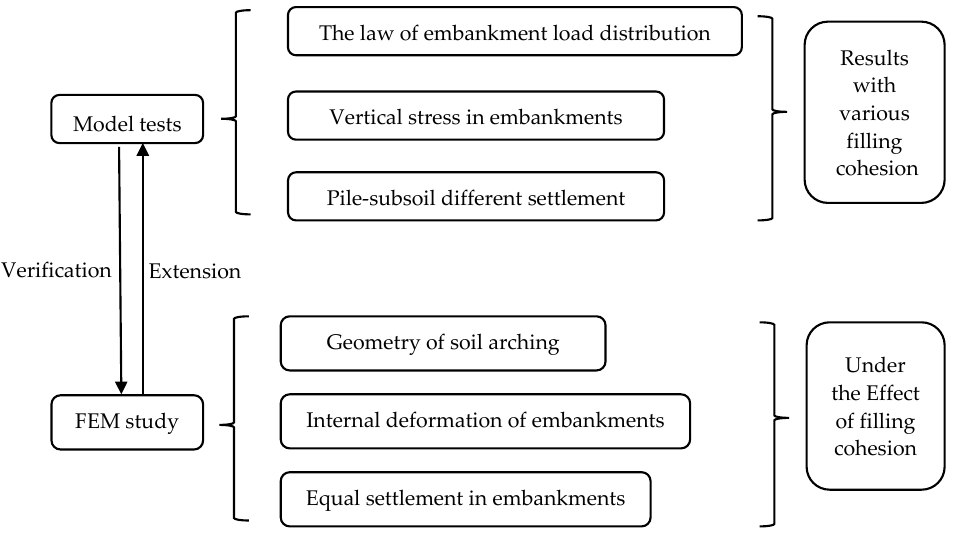
Figure 1. The flowchart of the research methodology.